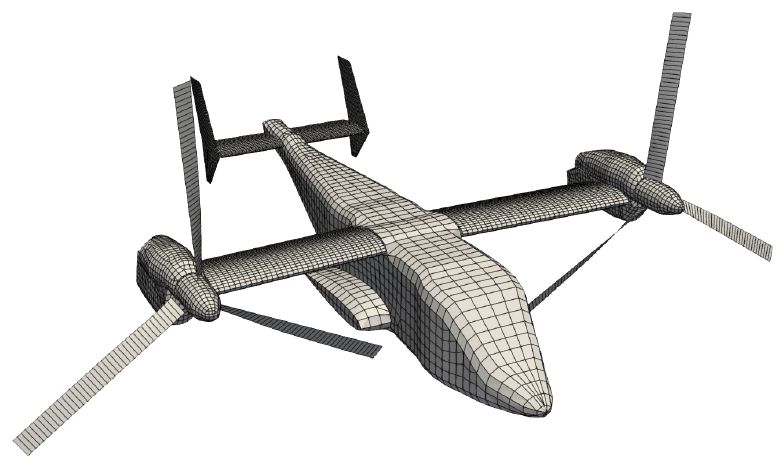
Figure 13. Aerodynamic mesh of the XV-15 tiltrotor